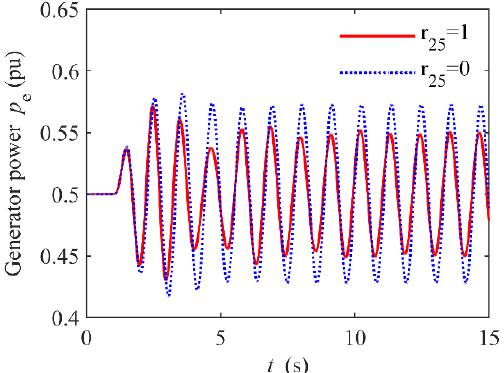
Figure 3. Comparison of power oscillations with different r 25 s .